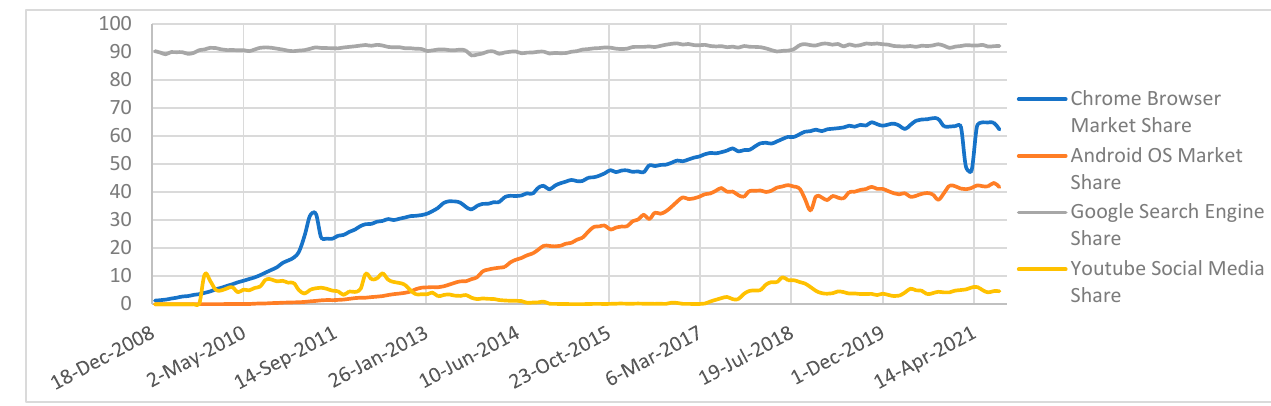
Figure 2. Market share of Google companies, %.